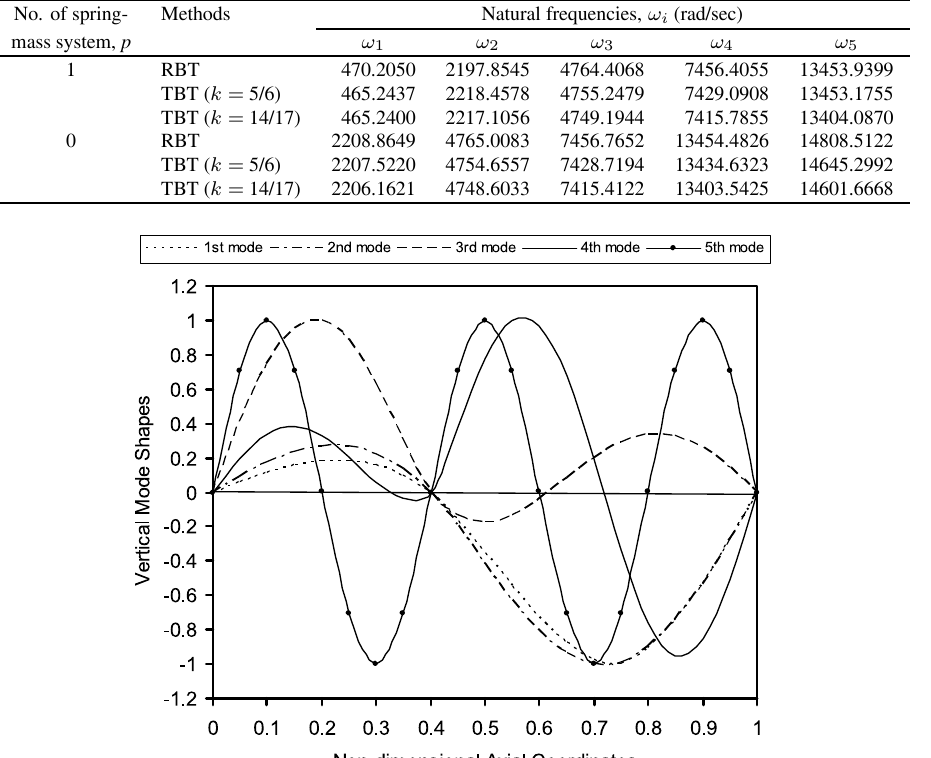
Fig. 6. The fi rst fi ve mode shapes for the model with one spring-mass system of Reddy-Bickford